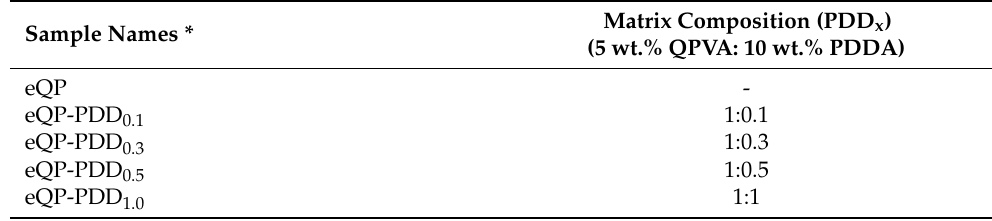
Table 1. Composition of the samples.